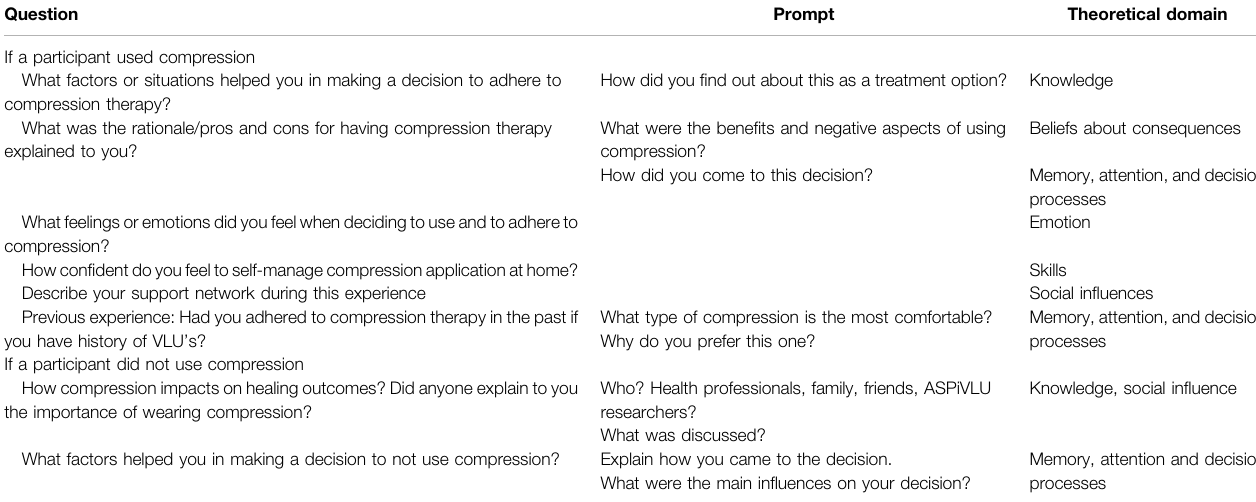
TABLE 1 | The interview guide: Selected questions and matched theoretical domains.